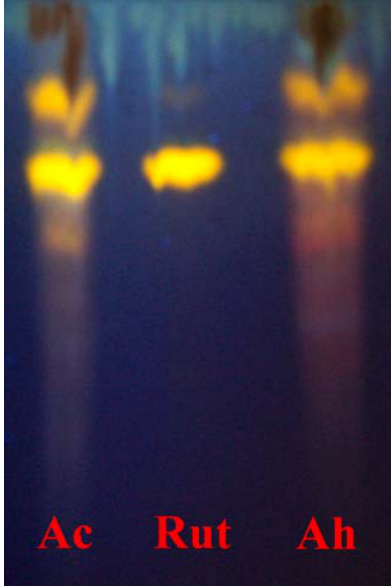
Figure 1. Thin-layer chromatography